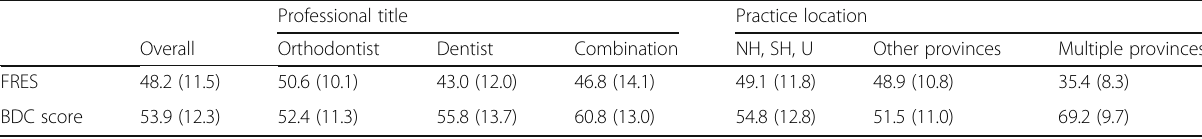
Table 3 FRES and BDC score means of website information and design, respectively (in parentheses, the standard